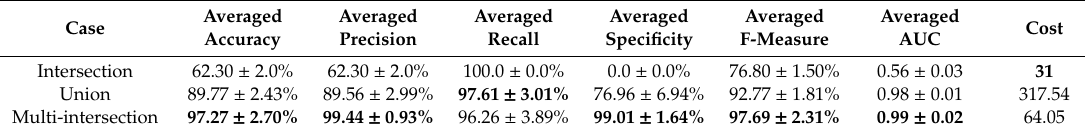
Table 14. Multiple combinations of scoring functions and their respective results.